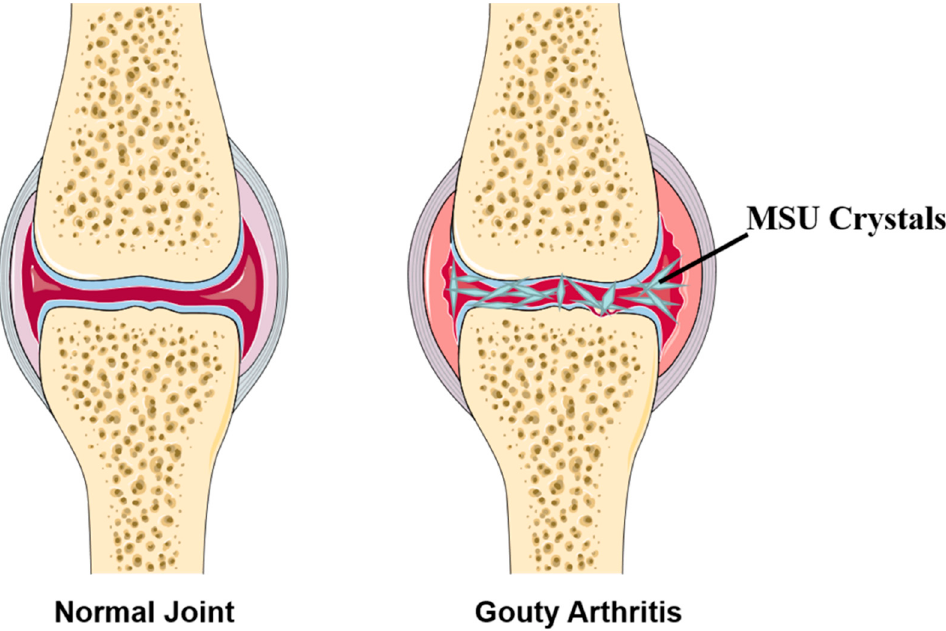
Figure 1. Abridged general view of normal joint and Gouty Arthritis (GA).